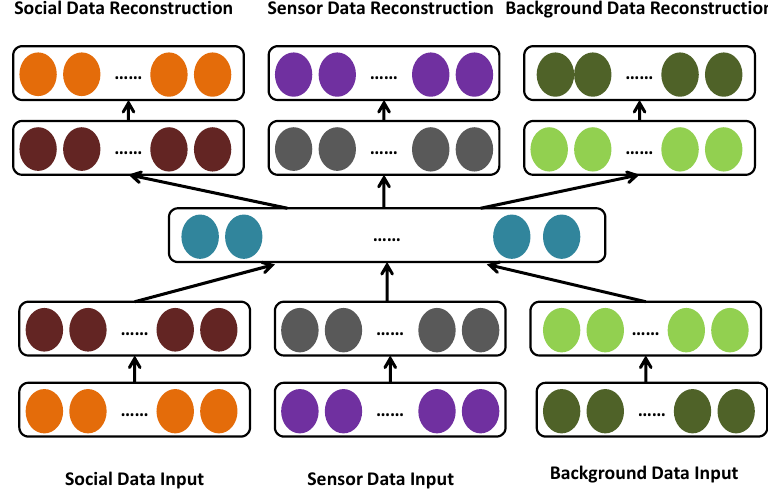
Figure 4. Urban knowledge fusion of learning latent